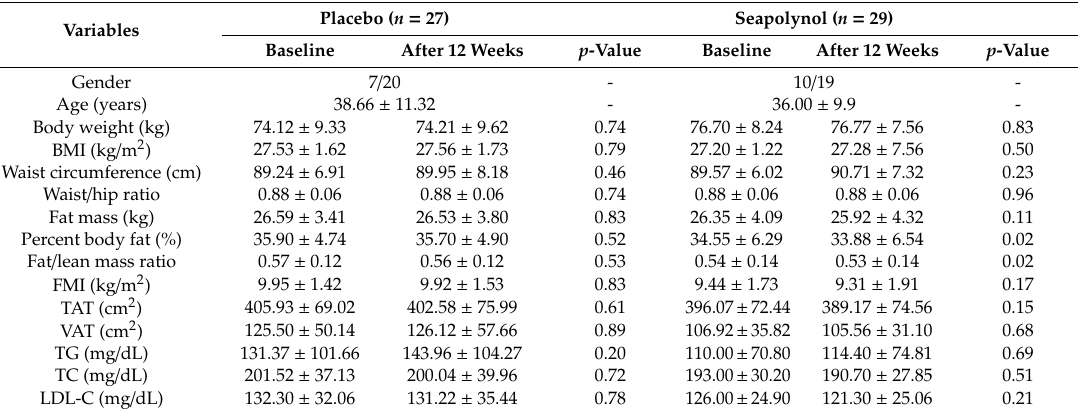
Table 1. Clinical characteristics of the study